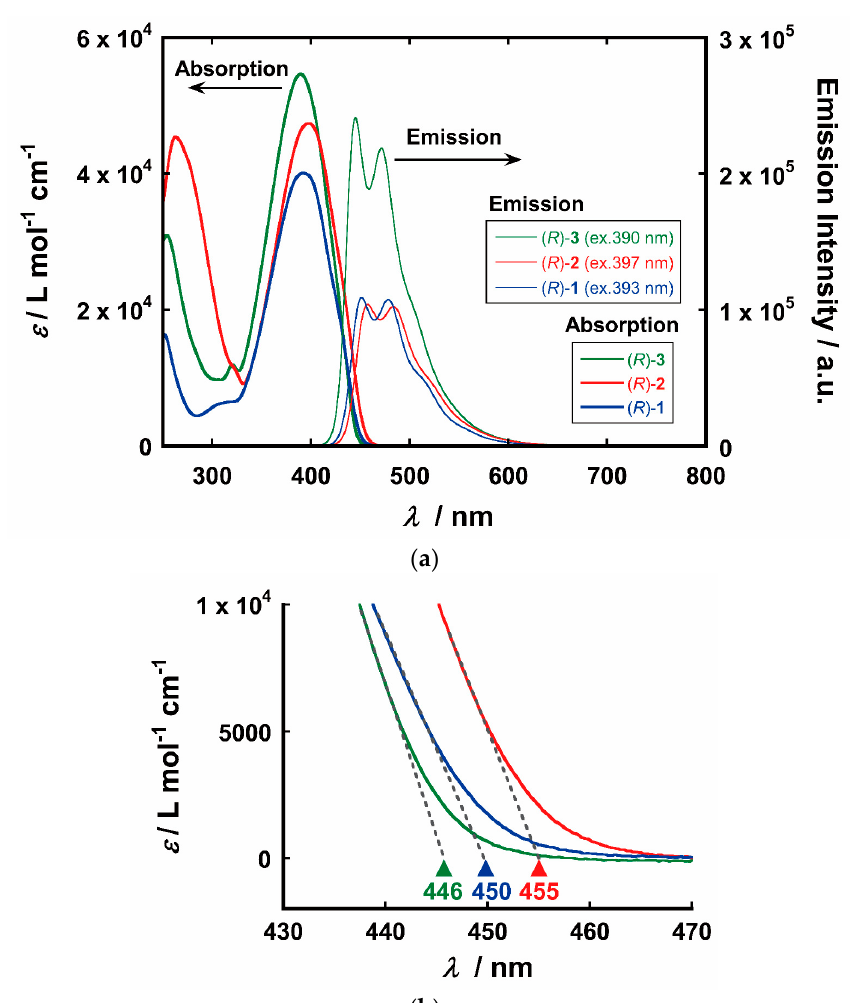
Figure 8. ( a ) UV–vis absorption and photoluminescent spectra in THF dilute solution (10 μ M) of ( R )- 1 , ( R )- 2 , and ( R )- 3 . ( b ) The magnified UV–vis absorption spectra in ( a ). Each triangle marks in the inset of absorption spectra depicting the absorption edge of ( R )- 1 (blue), ( R )- 2 (red), and ( R )- 3 (green). Table 2. Spectroscopic properties of ( R )- 1 , ( R )- 2 , and ( R )- 3 in a dilute THF solution (10 μ M). Compound